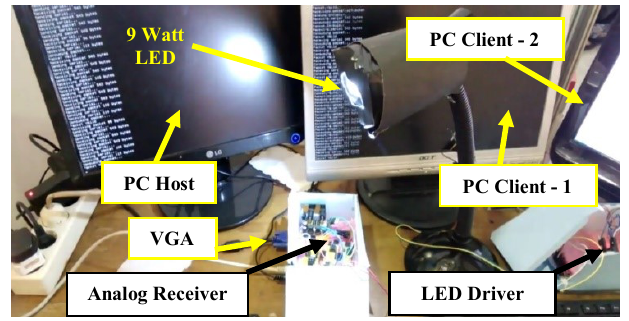
Figure 12. A photograph of MAC layer functional